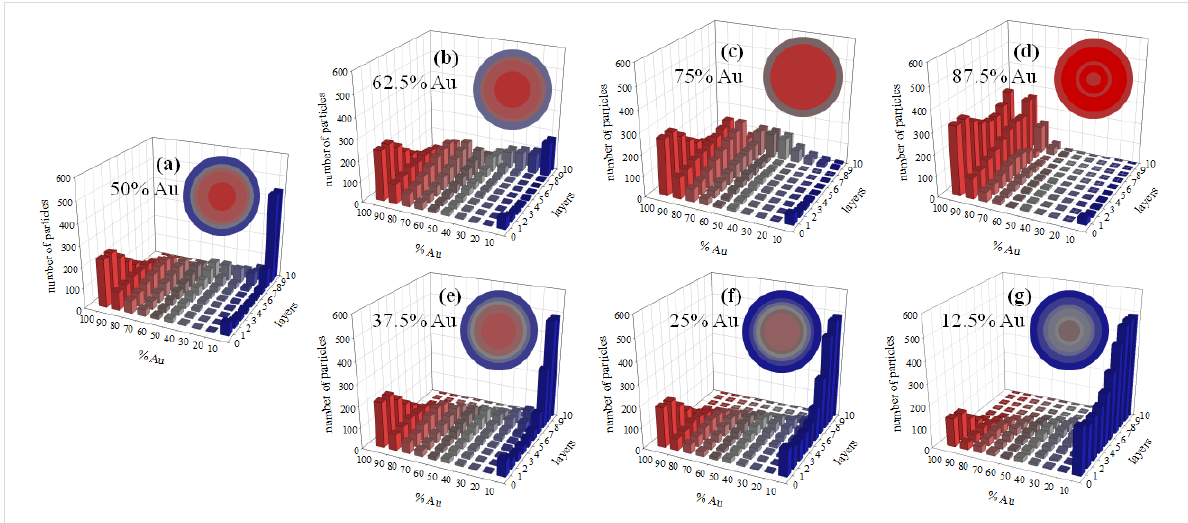
Figure 1: Histograms reprensent the number of particles with a given percentage of Au in each layer, from the nanoparticle core to the surface. Syn- thesis conditions: reduction rate ratio (v Au /v Pt = 10), film flexibility ( k ex = 5, f = 30) and average reactant concentration ( = 64 metal ions in a micelle). Each histogram shows a different proportion between metals salts: a) 50% Au, micelle. Scheme color: blue (0–45% of Au), grey (45–55% of Au), red (55–100% of Au). Brighter red corresponds to more Au. The circles in each histogram represent the nanoparticle structure in concentric layers, keeping the same color